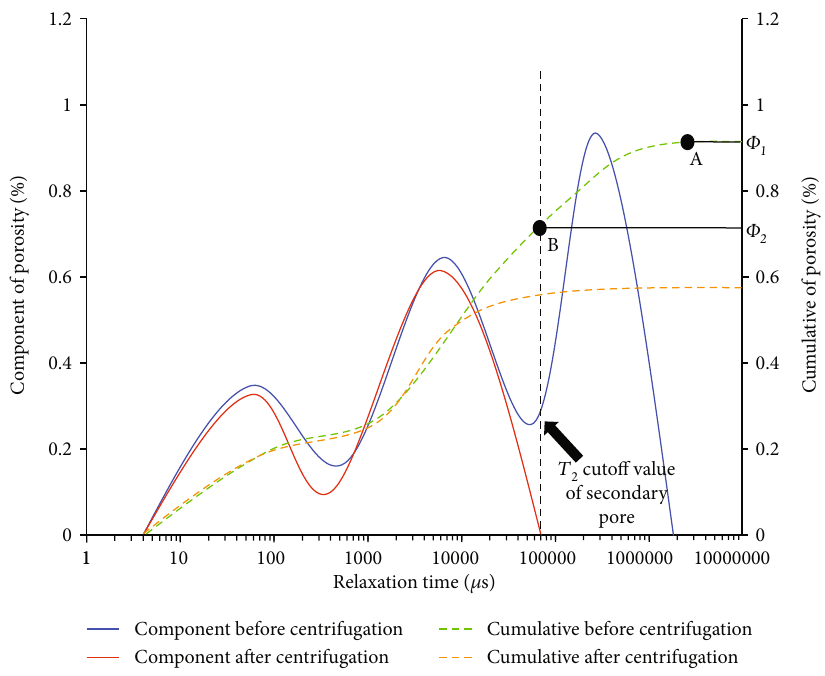
Figure 1: NMR T spectrum of reef limestone reservoir core before and after 2